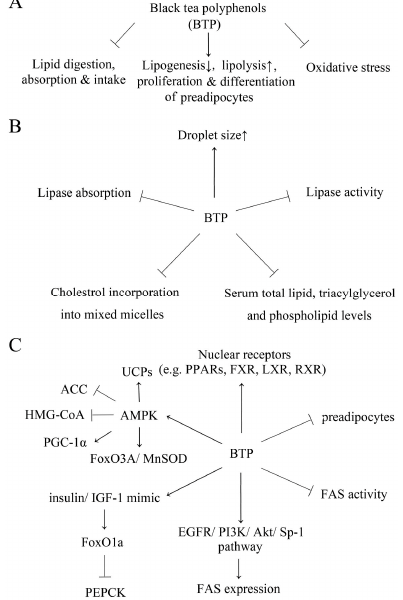
Figure 1. Anti-obesity mechanisms of black tea polyphenols. ( A ) General anti-obesity mechanisms of black tea polyphenols. Detailed anti-obesity mechanisms of black tea polyphenols include inhibiting lipid digestion, absorption and intake, thus reducing calorie intake ( B ); attenuating lipogenesis, enhancing lipolysis and decreasing the differentiation and proliferation of preadipocytes ( C ); and suppressing oxidative stress.